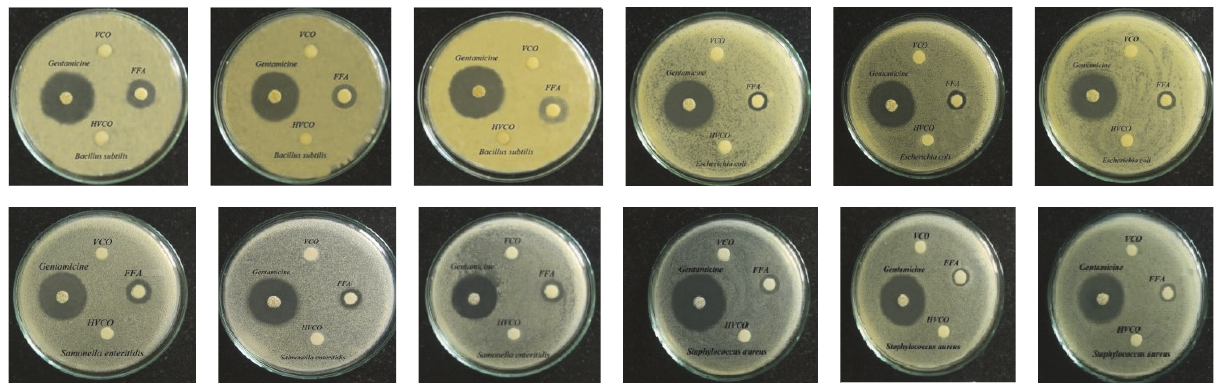
Figure 3: Antibacterial activity of VCO, HVCO, FFAs, and gentamicin against 4 types of tested bacteria.